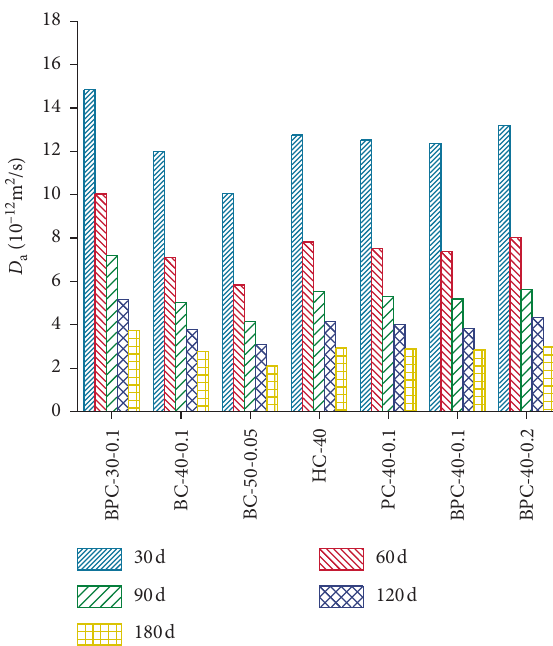
Figure 10: Apparent chloride diffusion coefficient of